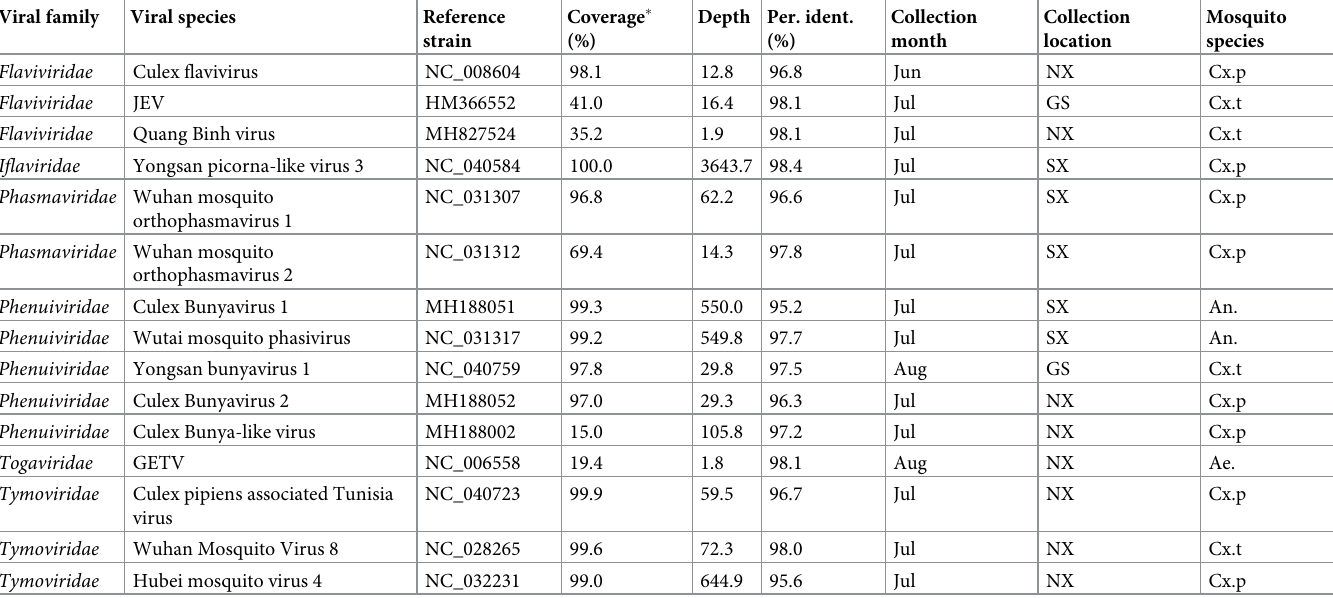
Table 2. Characterization of selected species of mosquito-borne